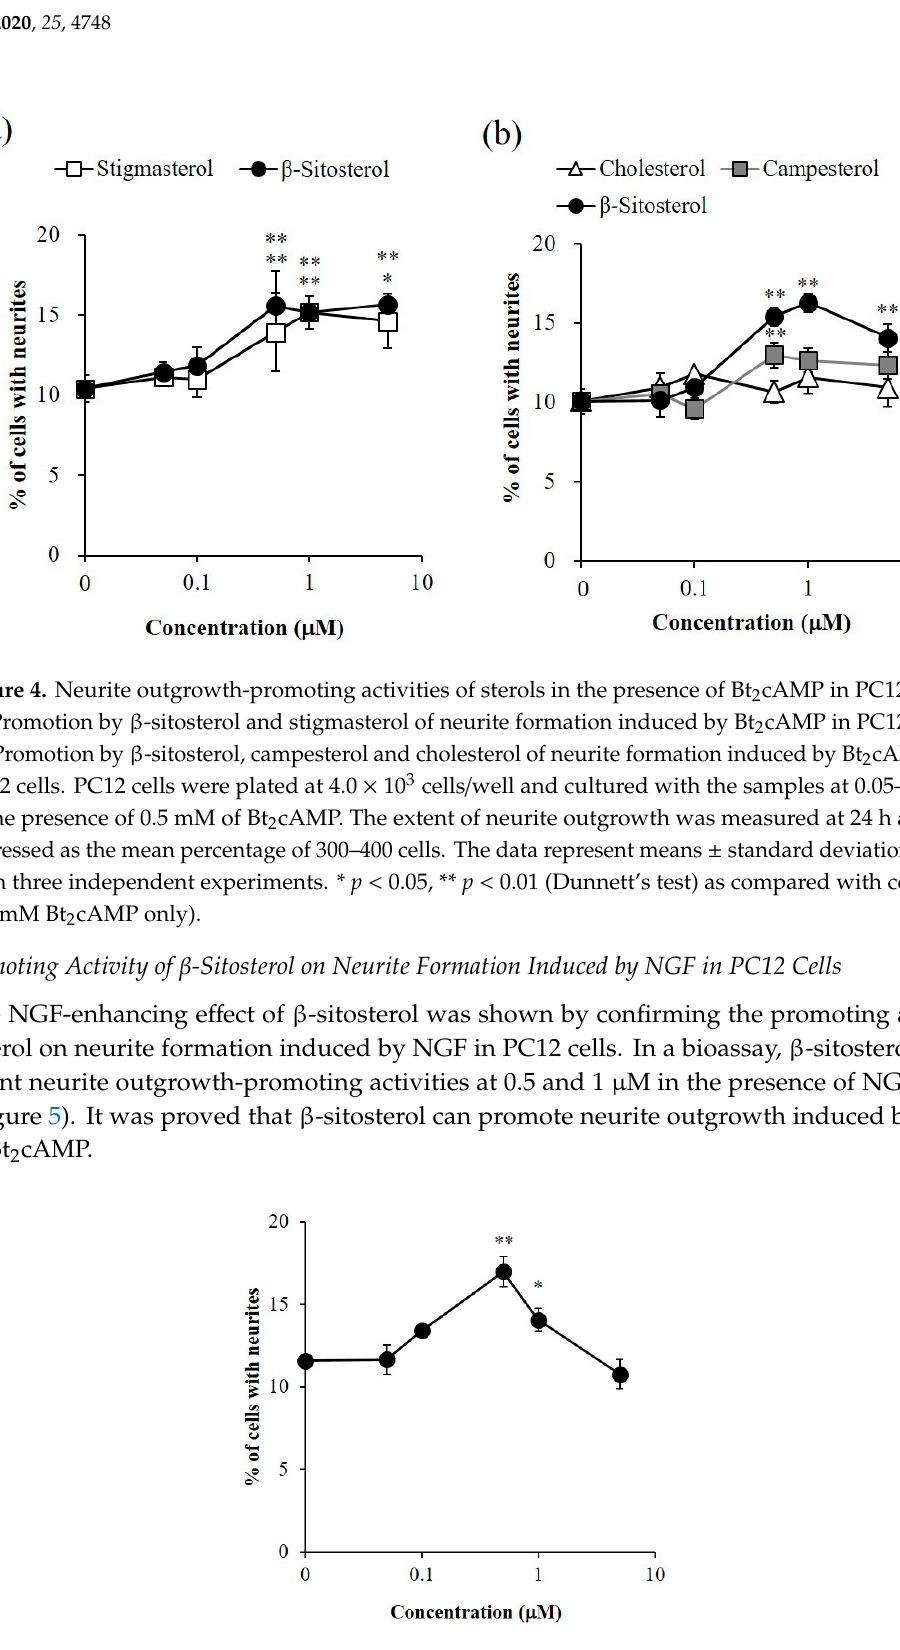
Figure 6. Immunostaining of neurofilaments of PC12 cells with differentiated neurites stimulated by β -sitosterol in the presence of NGF. PC12 cells were incubated for 48 h without or with NGF (10 ng/mL) and β -sitosterol (0.5 μ M) or with NGF (10 ng/mL) alone. Immunostaining was performed with rabbit anti-neurofilament antibody, followed by treatment with fluorescein isothiocyanate- conjugated goat anti-rabbit IgG. The nuclei of PC12 cells were treated with 4 ′ ,6-diamidino-2- phenylindole (blue) and examined under a fluorescence microscope. ( a ) Phase contrast, ( b ) DAPI-